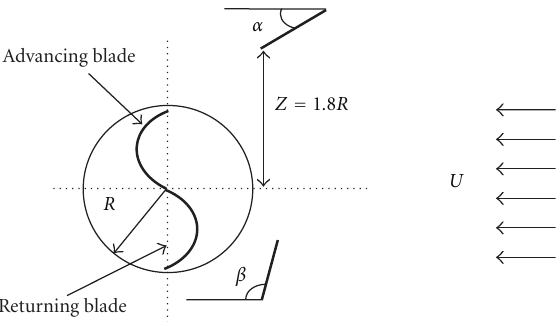
Figure 7: Schematic of modified Savonius rotor with space para- meters of two deflector plate ( Z = R ).